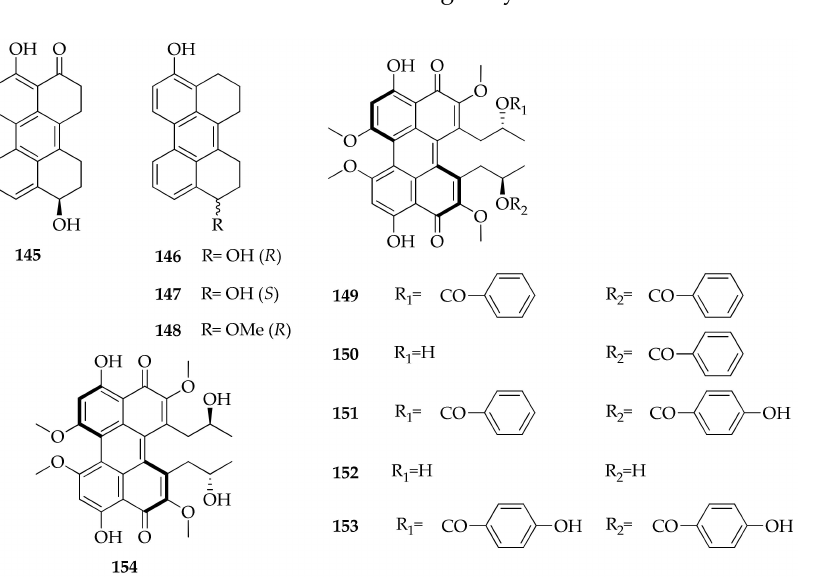
Figure 23. Structures of perylenequinones.